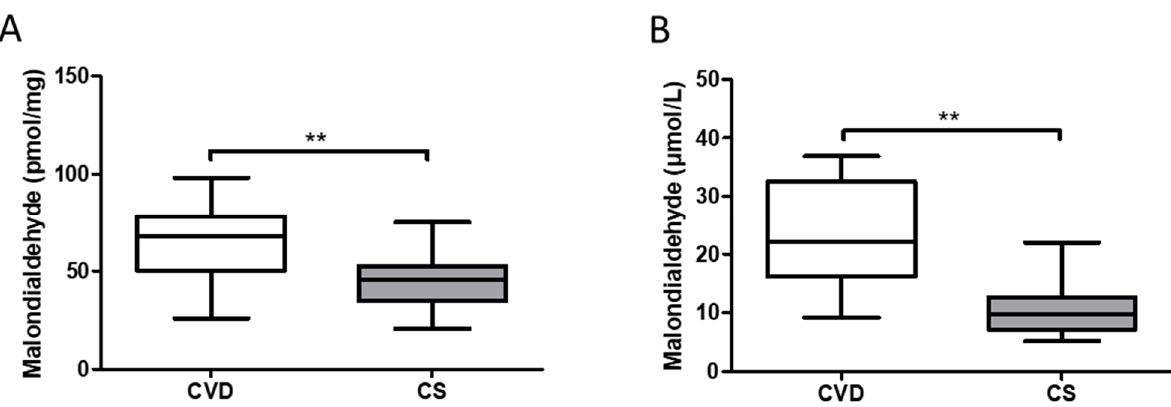
Figure 5. ( A ) Malondialdehyde (MDA) levels in newborn umbilical cord (pmol/mg). ( B ) Malondialdehyde (MDA) levels in newborn plasma ( μ mol/L). CVD = Chronic Venous Disease, CS = Control without venous pathology. p < 0.01 (**).